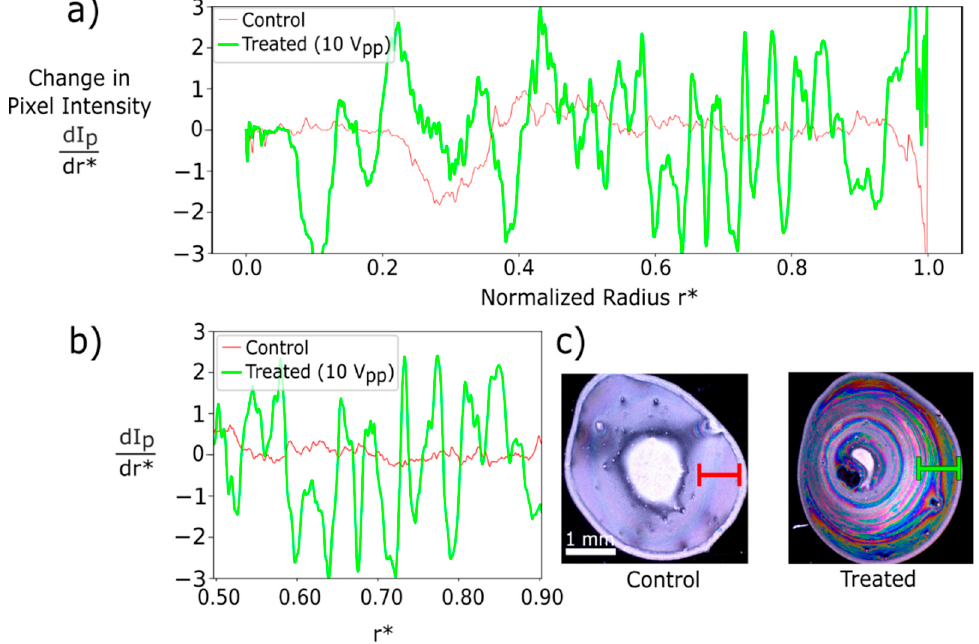
Figure 5. ( a ) Derivative of pixel intensity ( dIp ) over the normalized radius (r*) for a control and (cid:2914)(cid:2928)∗ dr ∗ electric field ‐ treated (10 V pp ) sample. The control signal shows only slight variation, with values close to or at zero, indicating little to no color banding. The experimental signal shows high variation (cid:2914)(cid:2893)(cid:2926) throughout the deposit region indicating a high degree of color banding. ( b ) ( ) from 0.5 < r*< 0.9 (cid:2914)(cid:2928)∗ highlighting the difference between the control and experimental samples where color banding is seen. ( c ) Images of control and experimental samples with overlays showing the line profile over the region 0.5 < r* < 0.9.